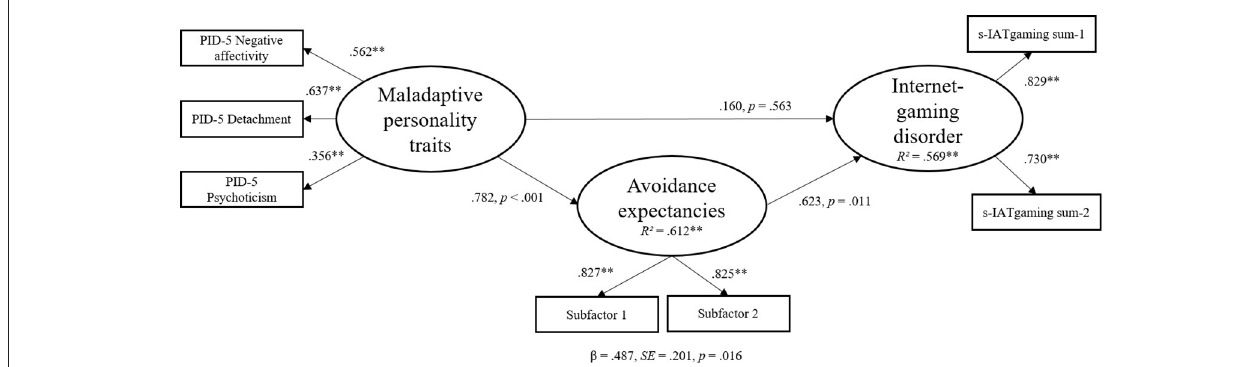
FIGURE 2 | Results of the structural equation model. Results of the structural equation model with IGD as dependent variable including factor loadings on the described latent variables and the accompanying β -weights, p –values, and residuals.